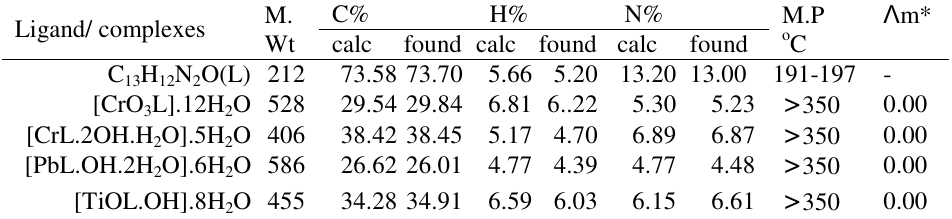
Table 1. Some physical properties of the Schiff base and its complexes Ligand/